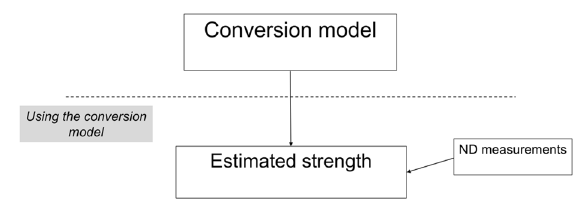
Figure 1. Usual strength estimation process.